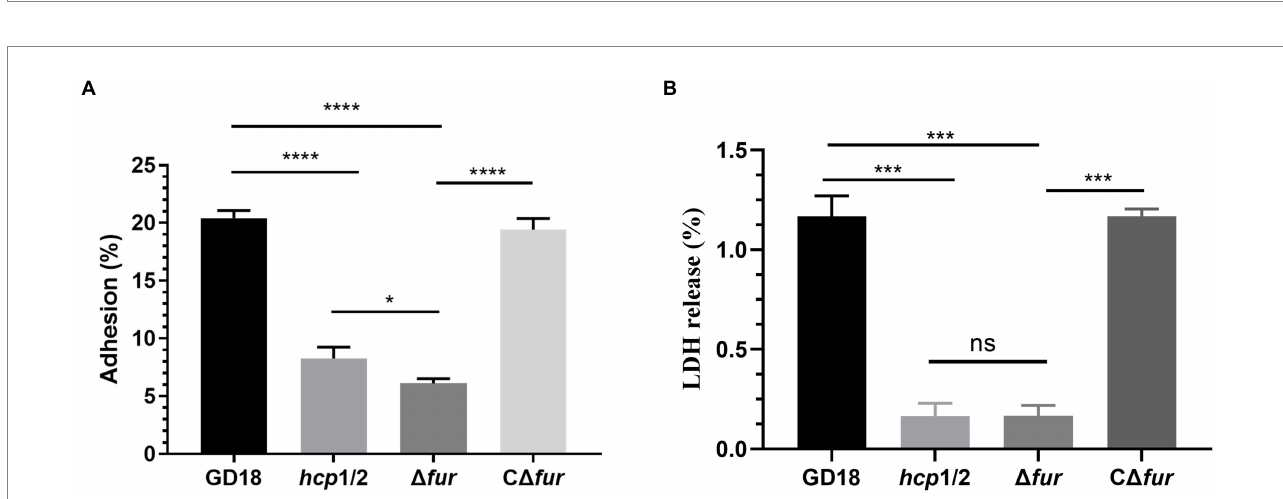
FIGURE 5 Fur contributes to cell adherence and cytotoxicity in vitro . (A) Adhesion rate of the WT and mutant strains. (B) Cytotoxicity results after 2 h of incubation. Δ hcp 1/2 mutant group was set as the T6SS defective control group. The error bars represent mean ± standard deviations from three independent experiments (* p < 0.05; *** p < 0.001; **** p < 0.0001; ns, no